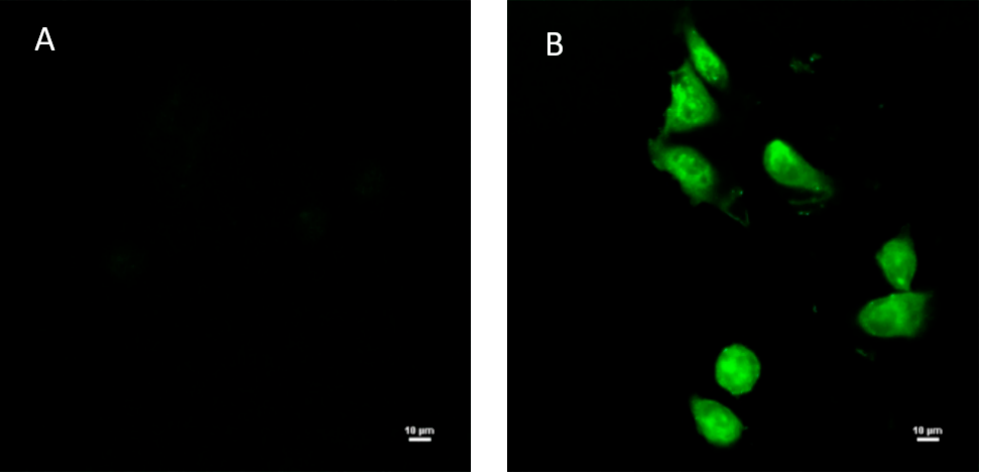
Figure 4. Fluorescent images of HUVEC cells in the absence of Ab ( A ) and titrated with a solution of green fluorescent Ab 5 μ g/mL ( B ) revealing the presence of a high density of integrins α v β 3 . Scale bar: 10 μ m.